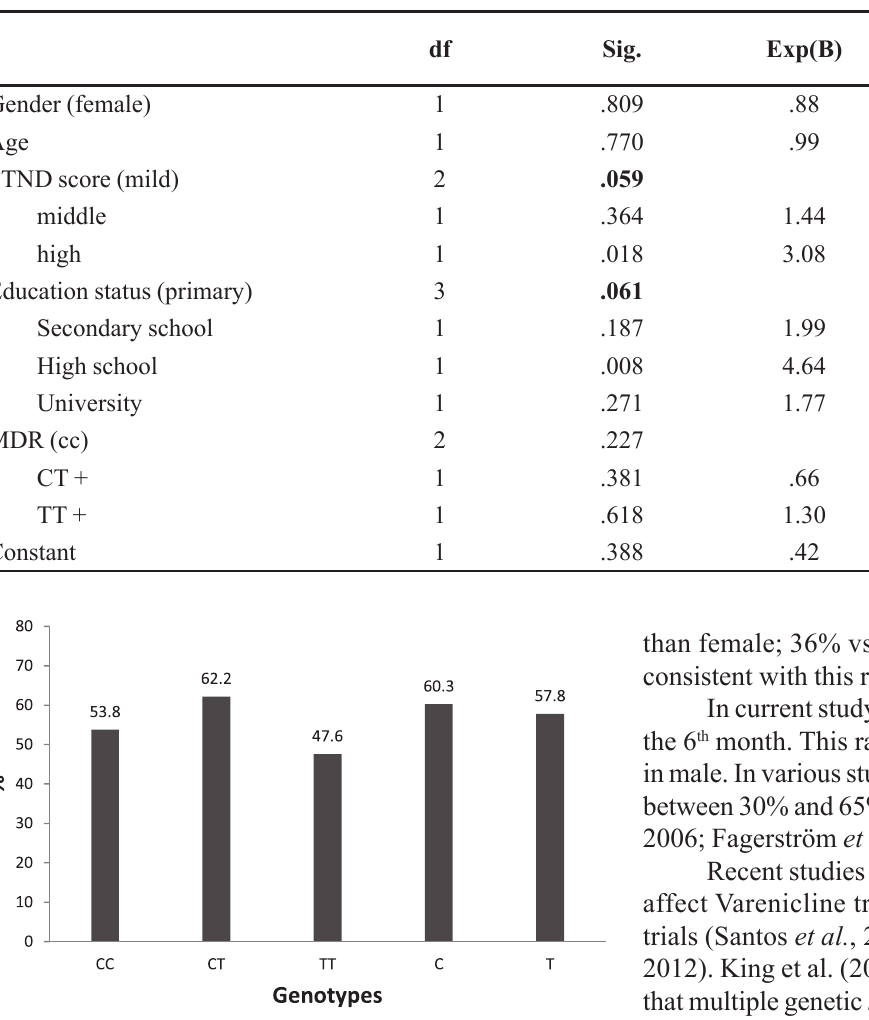
TABLE V - Effective Factors on Smoking Cessation Success According to Regression Analysis